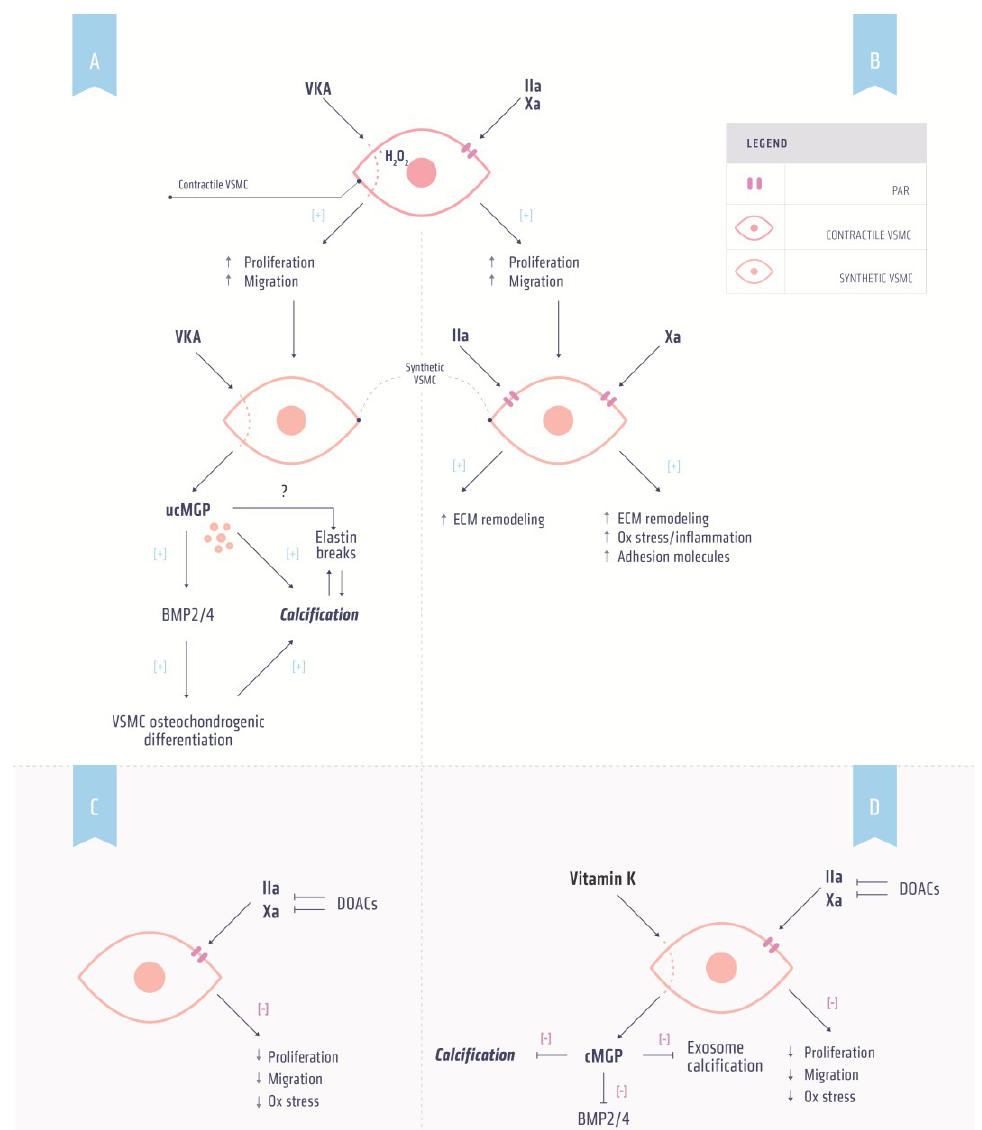
Figure 2. Effects of anticoagulants and vitamin K on vascular calcification. ( A ) Mechanism by which vitamin K antagonist (VKA) induces calcification. VKA induces phenotypic switching of contractile to synthetic vascular smooth muscle cells (VSMCs) by increasing oxidative stress resulting in increased proliferation and migration. Synthetic VSMCs secrete uncarboxylated matrix Gla protein (ucMGP) as a result of vitamin K depletion induced by VKA. ucMGP is unable to inhibit bone morphogenetic protein (BMP) 2 and 4, a marker for osteochondrogenic differentiation. Osteochondrogenic VSMCs are prone to calcification. Additionally, ucMGP is directly associated with increased calcification; ( B ) Thrombin and factor Xa induce non-hemostasis signaling via protease-activated receptors (PARs). Activation of PARs on contractile VSMCs can induce phenotypic switching resulting in increased proliferation and migration. PAR signaling in these synthetic VSMCs increases oxidative stress and adhesion molecules and induces extracellular (ECM) remodeling thereby facilitating calcification; ( C ) DOAC treatment in combination with ( D ) supplemental vitamin K administration has the potential to prevent both hypercoagulability and inhibit vascular